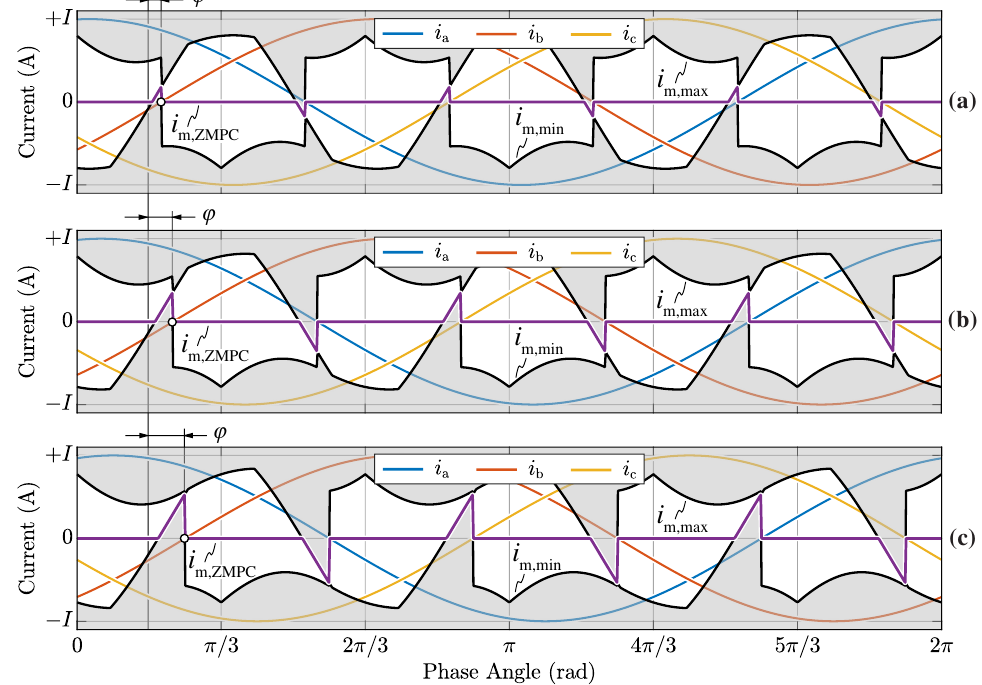
Figure 7. Mid-point current local average limits i m,max , i m,min for ϕ = 5° ( a ), ϕ = 10° ( b ) and ϕ = 15° ( c ) assuming M = 0.8. The mid-point current local average waveform obtained with zero mid-point current modulation (ZMPCPWM) is superimposed (i.e., i m,ZMPC